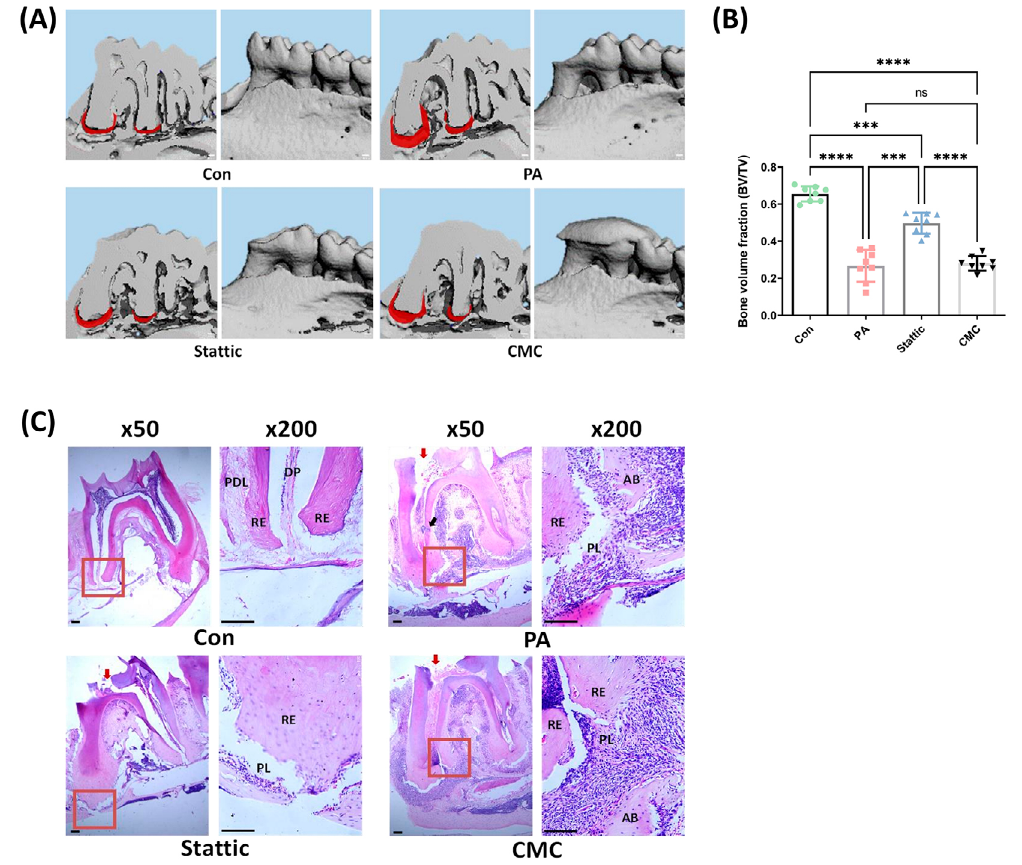
Figure 5- P. gingivalis infection caused radiographically detectable apical lesions in vivo , and systemic blockade of STAT3 alleviated bone resorption in P. gingivali s-derived murine apical periodontitis. (A), representative 3-D reconstruction images of the infected mandibles. Areas in red indicate the soft tissues surrounding the root apexes; scale bars, 100 μm. (B), analysis of the bone volume fractions (BV/ TV). (C), representative H&E staining results for the apical regions. Scale bars, 100 μm. Con, control group; PA, P. gingivalis -induced apical periodontitis group; Stattic, Stattic (supplemented with 0.5% carboxymethylcellulose) treatment of the AP group; CMC, 0.5% carboxymethylcellulose treatment of the AP group. BV, bone volume; TV, tissue volume. ***p<0.001, ****p<0.0001; ns, not significant. Red arrows in the H&E staining pictures indicate pulpal accesses; black arrow in the AP group indicates lateral root canal. PDL, periodontal ligament; DP, dental pulp; RE, root end; AB, alveolar bone; PL, periapical